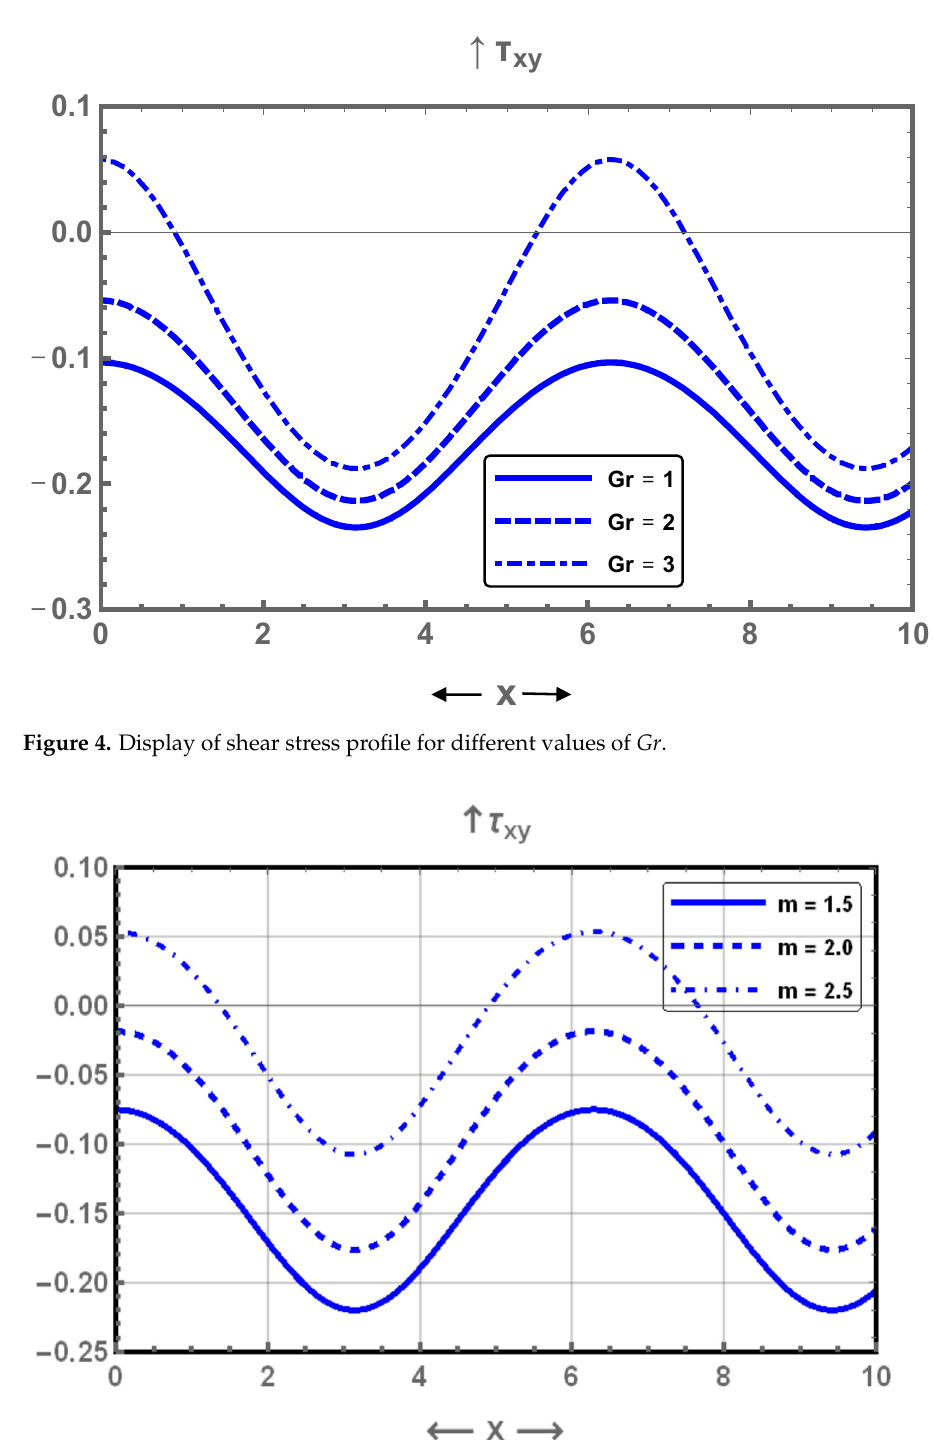
Figure 5. Display of shear stress profile for different values of m .